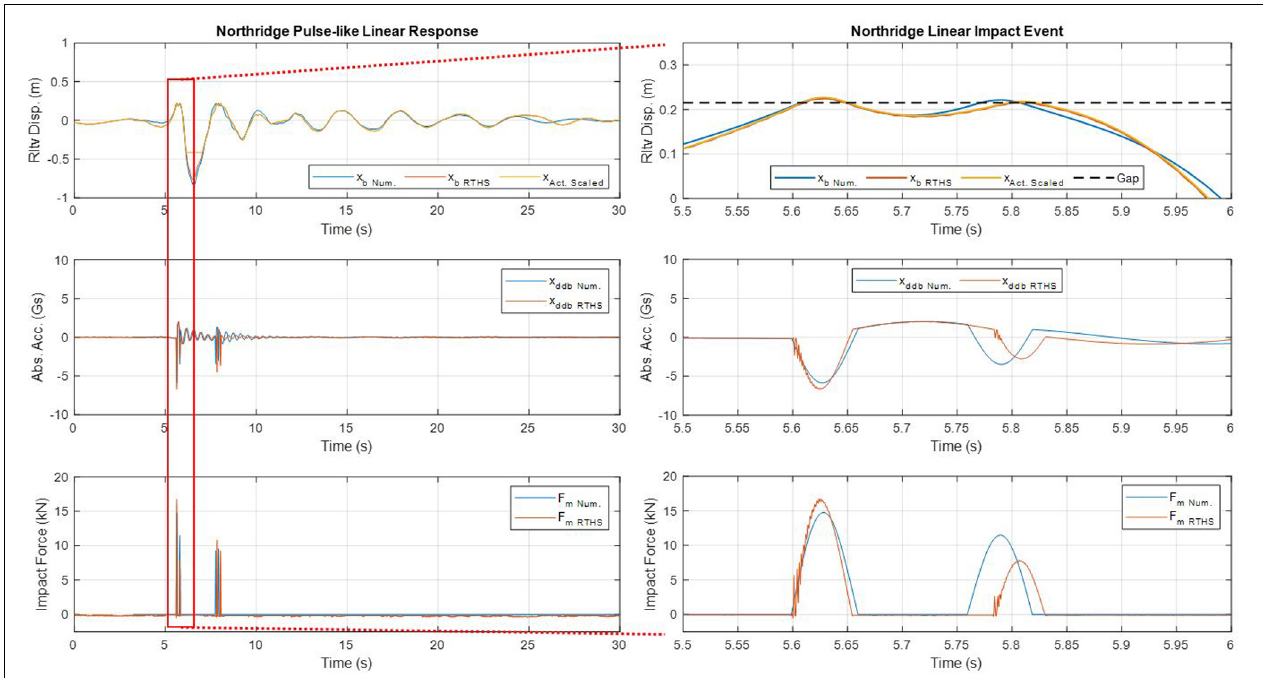
FIGURE 7 | Time history of the response to the Northridge Pulse-like ground motion for the linear impact scenario.